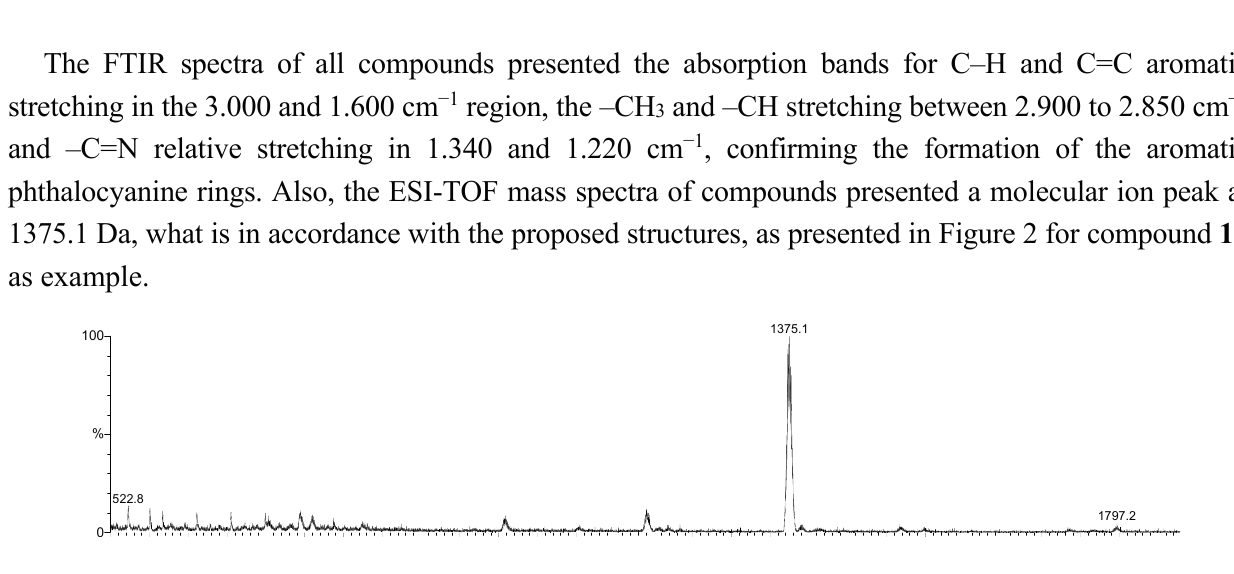
Figure 2. ESI-TOF positive mode mass spectrum of phthlalocyanine 10 .